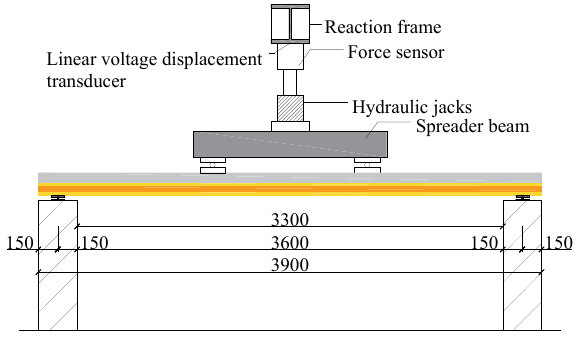
Figure 6. Residual load-carrying capacity test setup (units: mm).